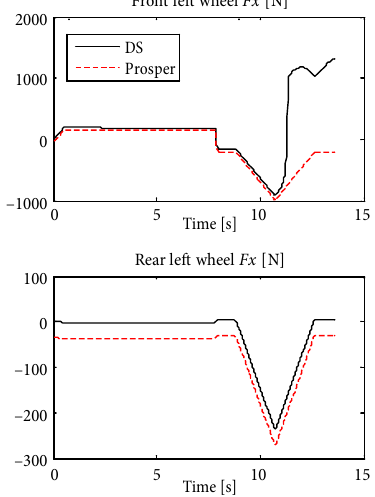
Fig. 13. Tires’ longitudinal forces – straight